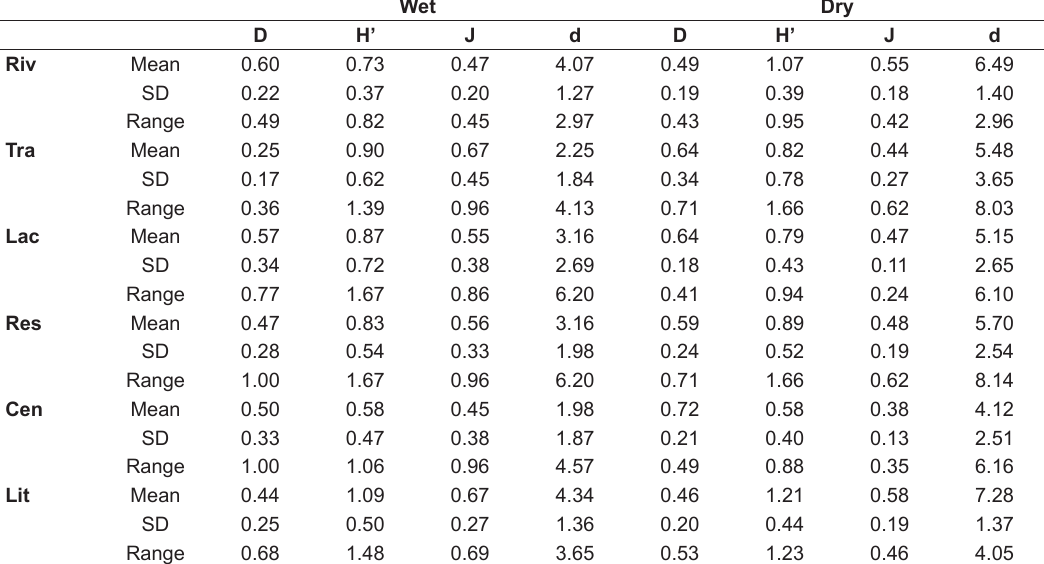
Table 6. Calculated values for Simpson’s dominance index (D), Shannon diversity index (H’), nats.ind –1 .; Pielou’s equability index (J) and Simpson’s richness index (d) to the benthic macroinvertebrates community from Itupararanga Reservoir, High Sorocaba Basin, SP, Brazil. Range; Mean and Standard Deviation = SD. Samples collected twice per season (wet and dry seasons) comprising the riverine (Riv), transitional (Tra) and lacustrine (Lac) zones. One sample from the center and another in the littoral for each sampling are considered. Were also calculated the means by samplings from the center (Cen) and from the littoral (Lit) as well as calculated for the reservoir (Res) as a whole. Wet